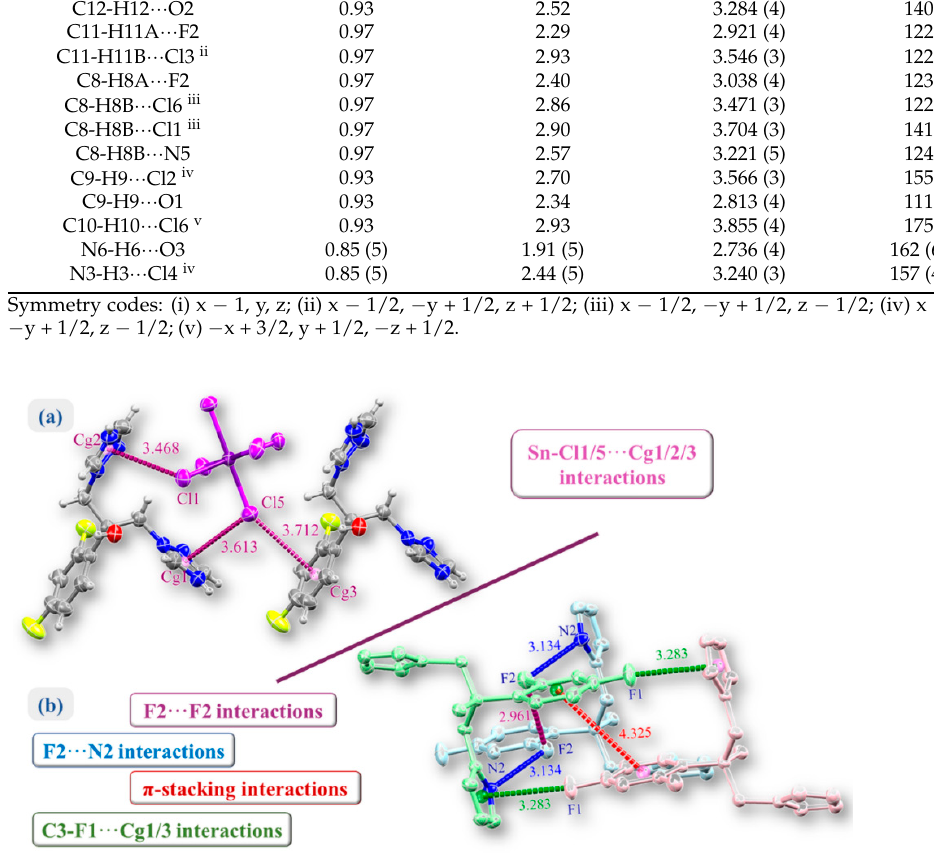
Figure 3. Details of the halogen bonding, X··· π , π -stacking interactions in (H2Fluconazole).SnCl 6 .2H 2 O (with 50% and 20% probability ellipsoids in ( a ) and ( b ), respectively).